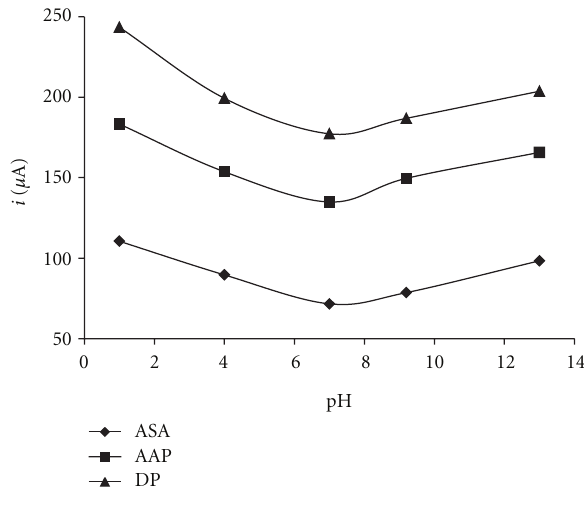
Figure 3: Plot of peak current versus pH.